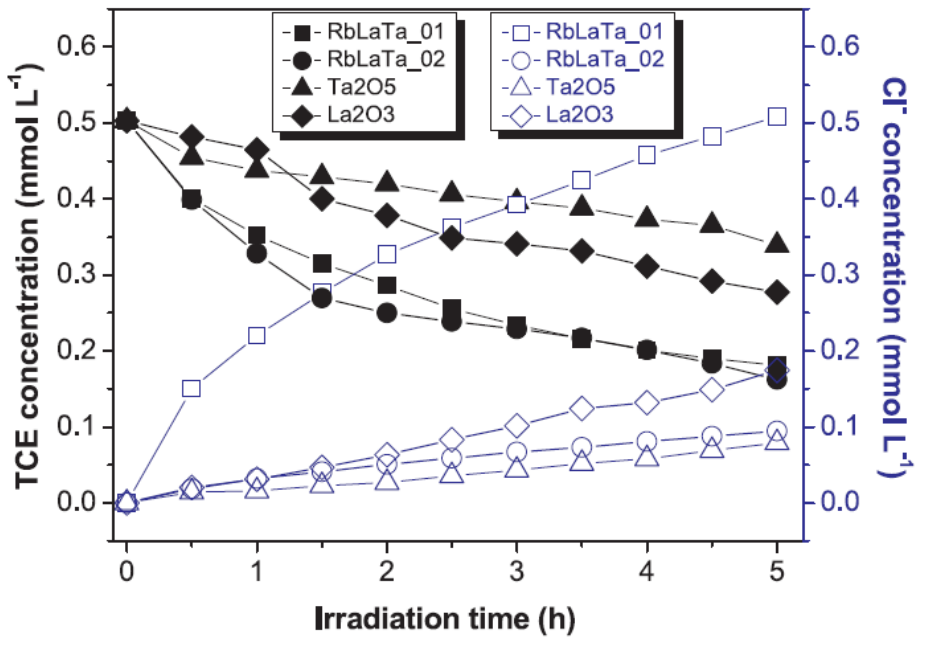
Figure 6. Time-evolution of TCE (closed symbols) and Cl − (open symbols) concentrations over RbLaTa_01(02) photocatalysts and precursors in the absence of methanol. Reaction conditions: initial concentration of TCE = 5 mg·L −1 ; simulated solar light, T = 18 °C, mass of catalyst = 0.05 g, volume of water = 110 mL. Reproduced with permission from ref. [48]. Copyright 2019 Elsevier.